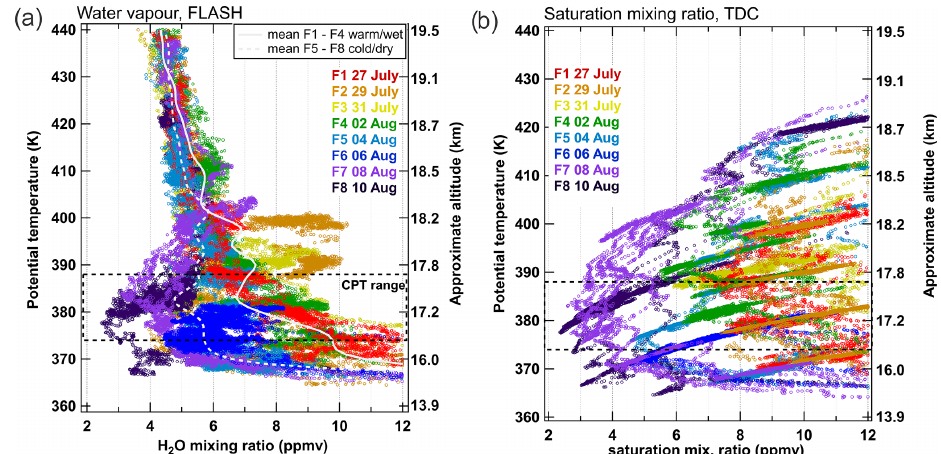
Figure 2. (a) Water vapour mixing ratio profiles taken by FLASH hygrometer. The flight dates are shown in the legend. The dashed rectangle marks the CPT vertical range. The white solid and dashed lines depict the mean water vapour profile for the warm/wet and cold/dry modes respectively (see Fig. 1c, d). (b) Saturation mixing ratio profiles computed from TDC measurements of temperature and pressure. The horizontal dashed lines in both panels mark the vertical range of CPT level encountered during the campaign. Note the strong variability of water vapour at the CPT level and accumulation of sharp enhancements in the lower